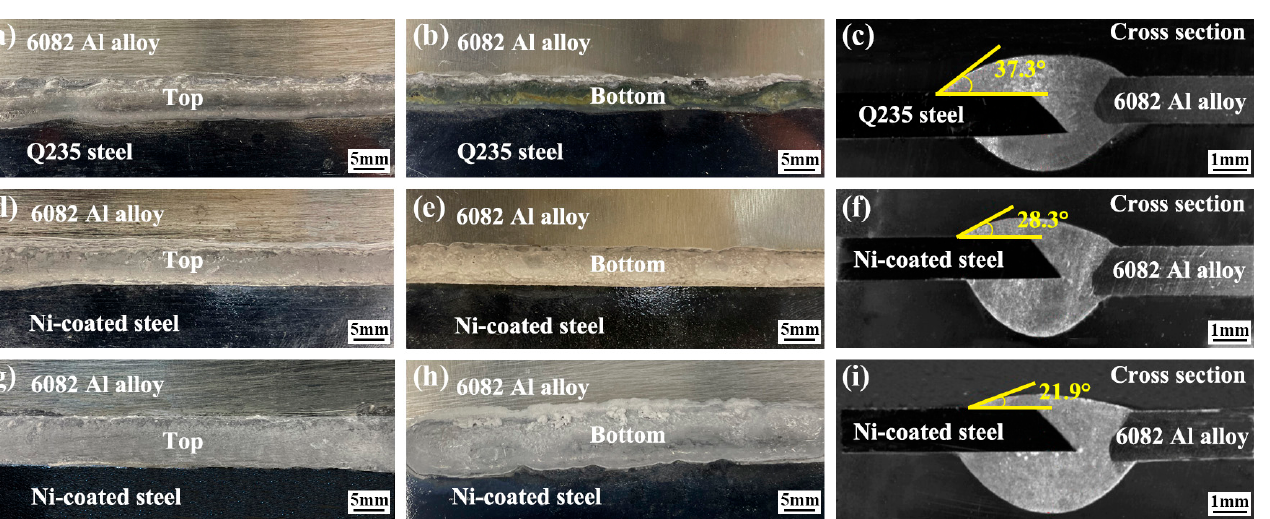
Figure 3. Macrostructure of joints under different thicknesses of Ni coatings: ( a–c ) without Ni coat- ing; ( d–f ) with 5 μ m Ni coating; ( g–i ) with 10 μ m Ni